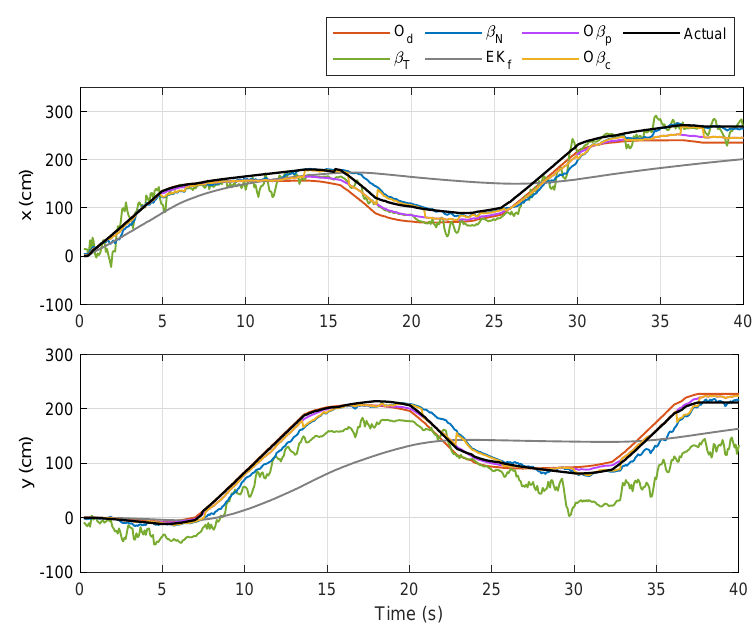
Figure 17. Localization of Node M in x - and y -directions in Trajectory 3.